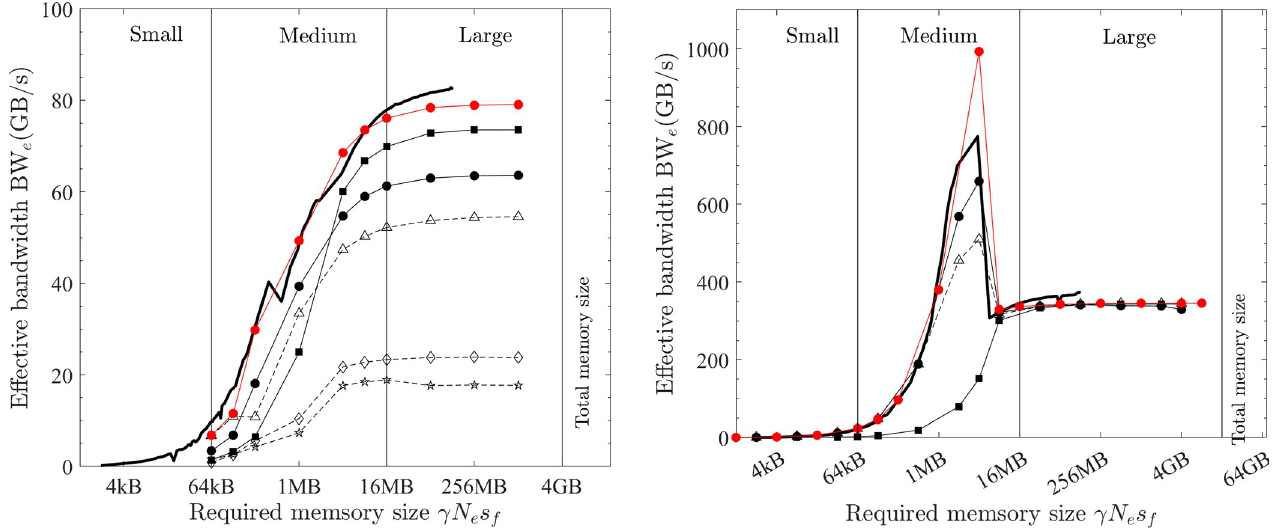
Fig 17. Optimal implementation of HEAT1D on the GPU platform (double precision; solid black line = benchmarked bandwidth; lines + symbols = effective bandwidth; red = VEC COPY; black = HEAT1D; filled circles = CUDA utilising L2 cache; hollow triangles = CUDA utilising shared memory; filled squares = XLA with slice and concatenation; hollow diamonds = XLA with convolution; hollow pentagons = XLA with roll). (a) PC. (b) HPC.